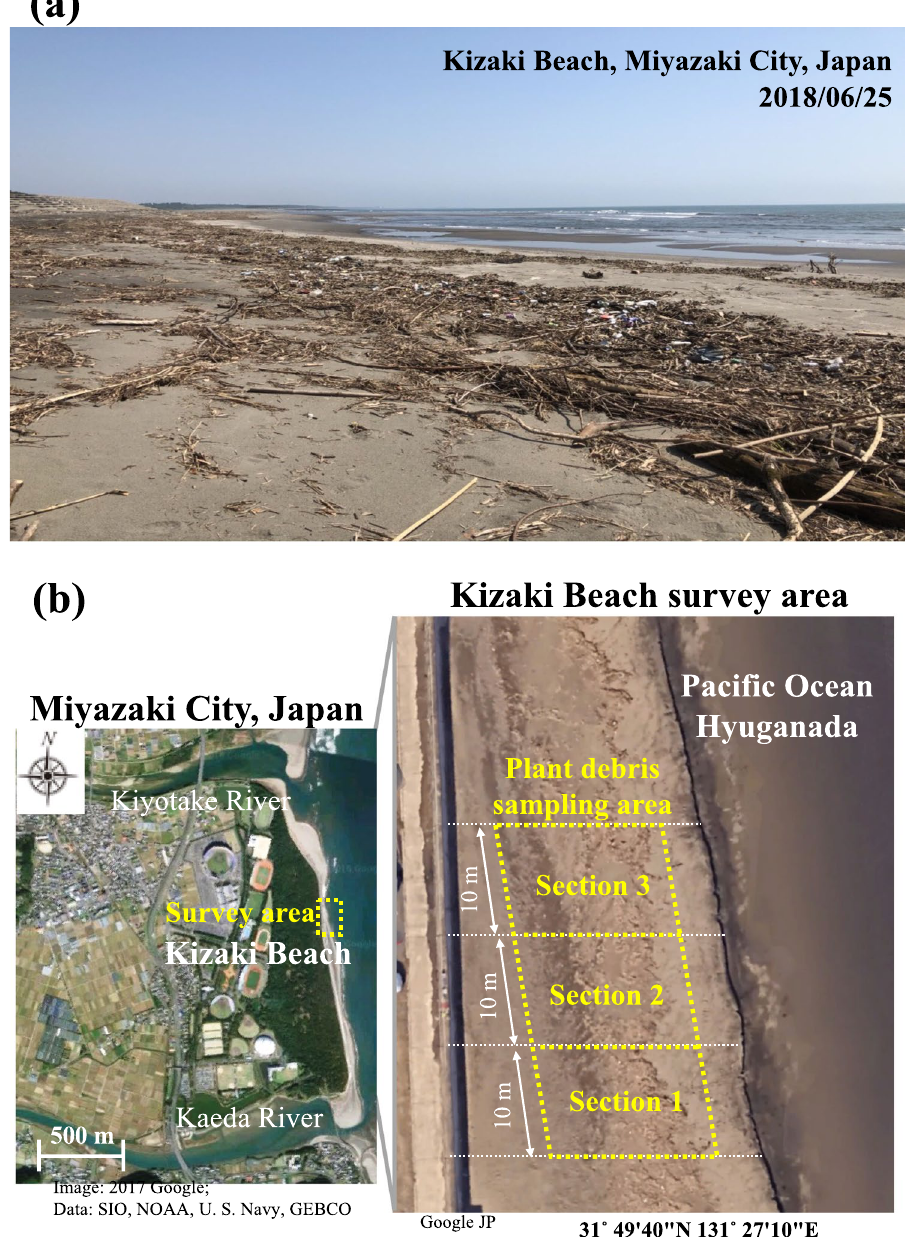
Figure 1. ( a ) Plant debris on Kizaki Beach on June 25, 2018. ( b ) Locations of sampling points on Kizaki beach, Miyazaki City, Japan. Most of the plant debris collected in this survey which accumulated near the high-water line of Kizaki Beach were branches and withered grass. All the plant debris was collected from three consecutive sections (Sections 1–3) along the high-water line at 10 m intervals ( b ) obtained from Google Earth (https:// earth. google. com/ web/@ 31. 82602 436,131. 44369 47,5. 75042 276a,5202. 77770 972d,35y,0h,0t,0r: https:// earth. google. com/ web/@ 31. 82805 704,131. 45286 349,1. 42880 734a,100. 50282 223d,35y,0h,0t,0r) and explanation and illustration were drawn in Microsoft Power Point (Version